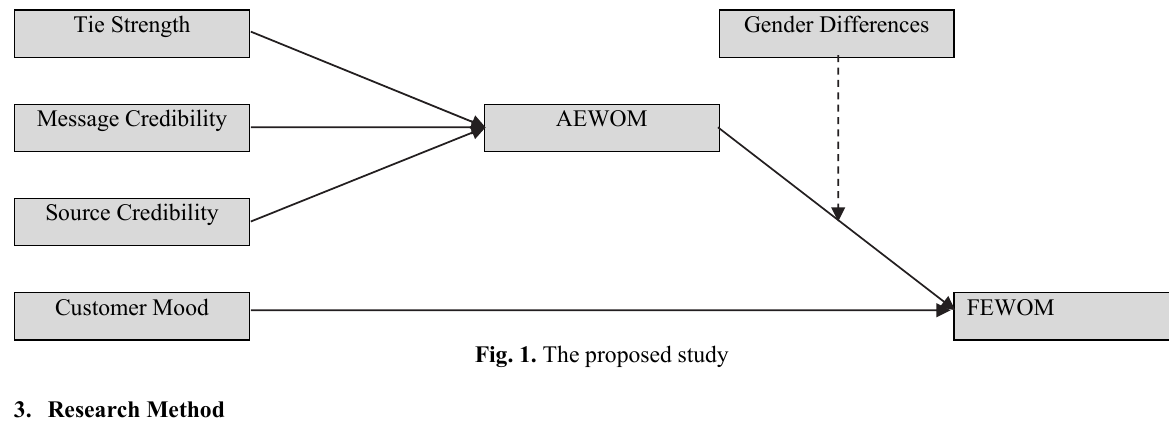
Fig. 1. The proposed